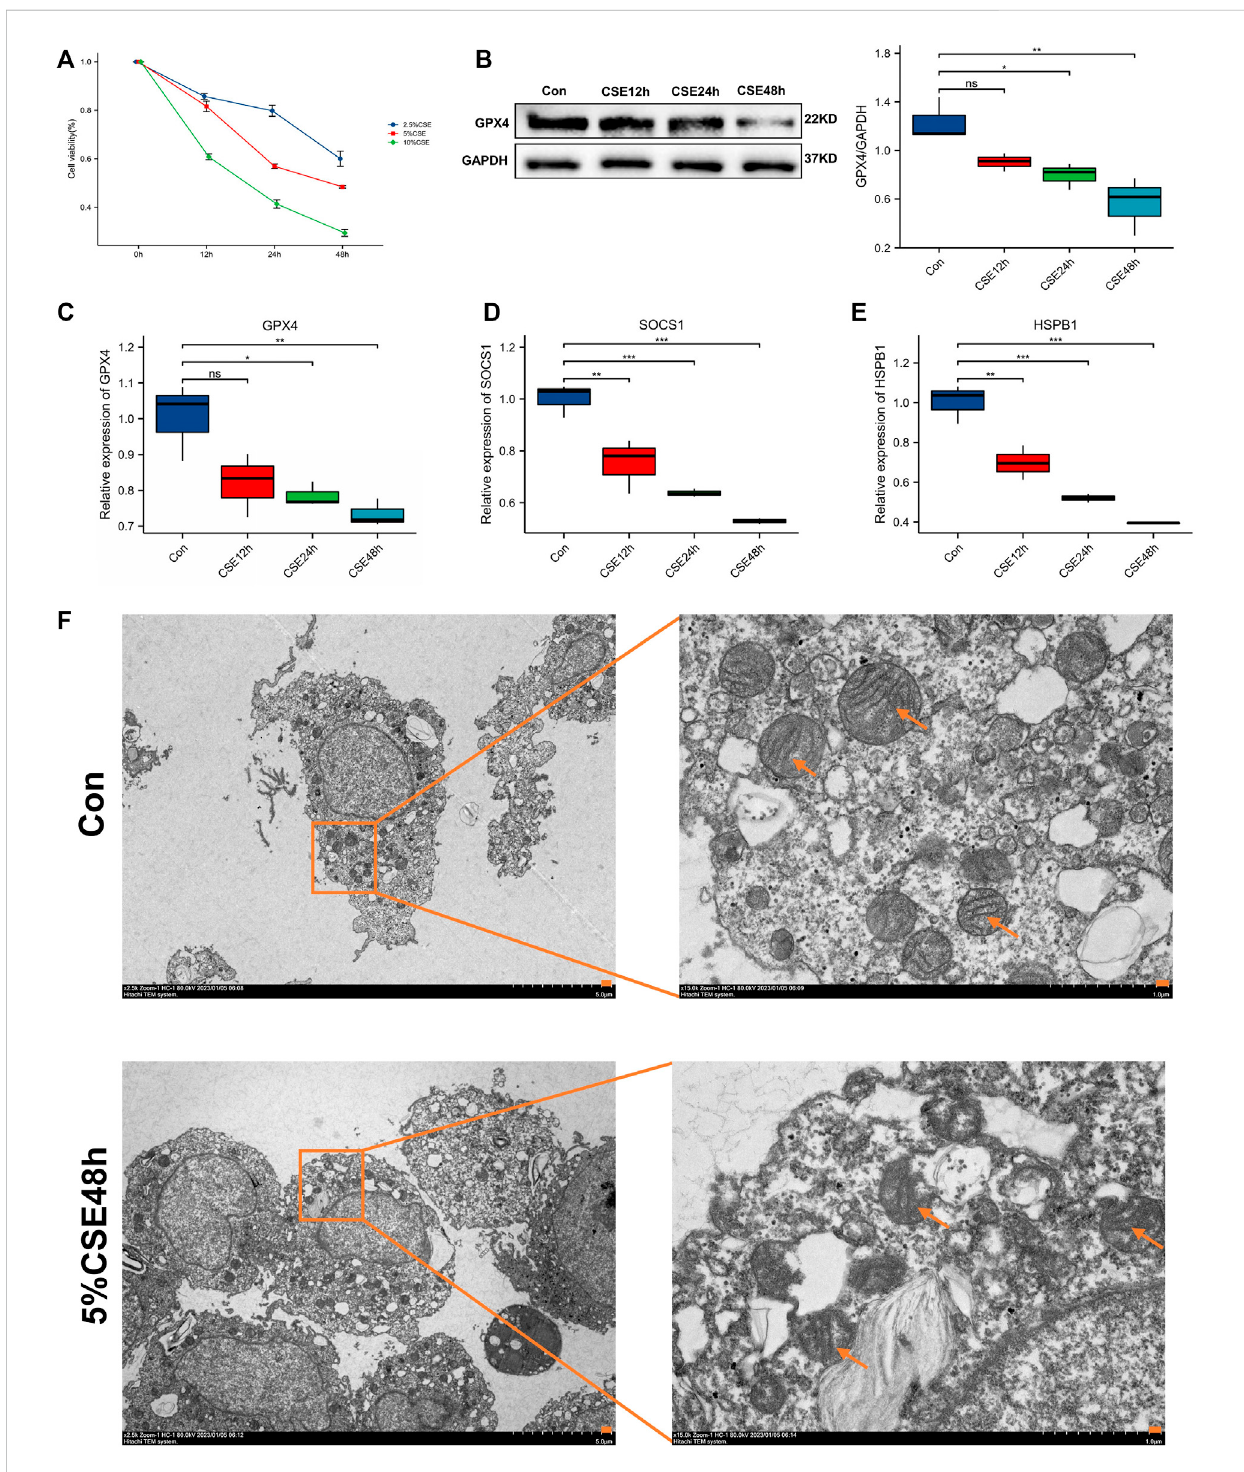
FIGURE 8 Cell viability and molecular validation. (A) Cell viability of macrophages stimulated by different concentrations of CSE. (B) Western blot for probing the expression of GPX4. (C) GPX4 expression after CSE stimulation at different time. (D) HSPB1 expression after CSE stimulation at different time. (E) SOCS1 expression after CSE stimulation at different time. * p < 0.05 , ** p < 0.01 , *** p < 0.001 , the CSE-induced group (CSE group) vs. the control group (Con). (F) Observation of mitochondrial morphology (orange arrows) using